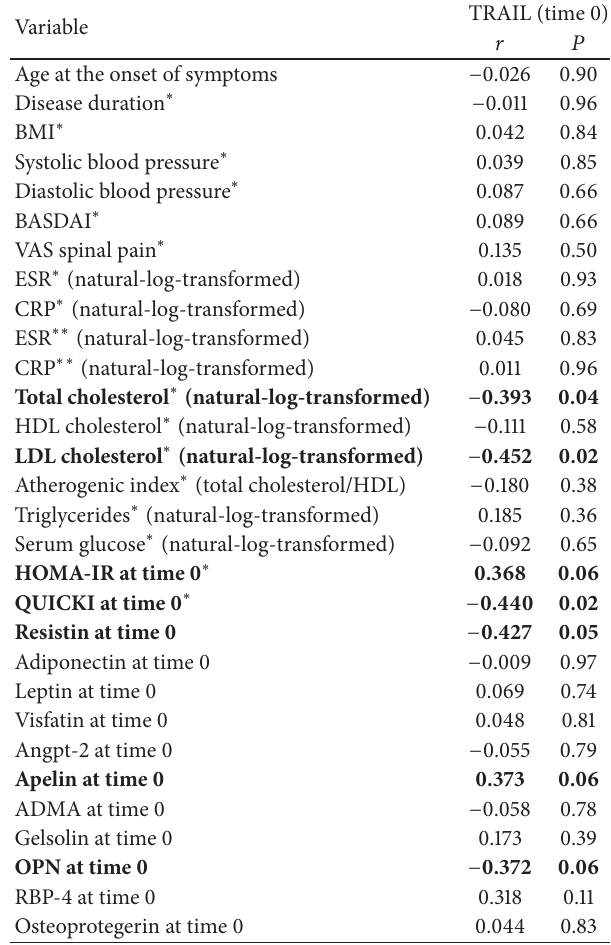
Table 2: Partial correlation of serum TRAIL prior to infliximab infusion (at time 0) with selected continuous variables adjusted for age at the time of the study, sex, and classic cardiovascular risk factors (dyslipidemia, smoking, obesity, and hypertension) in 30 patients with ankylosing